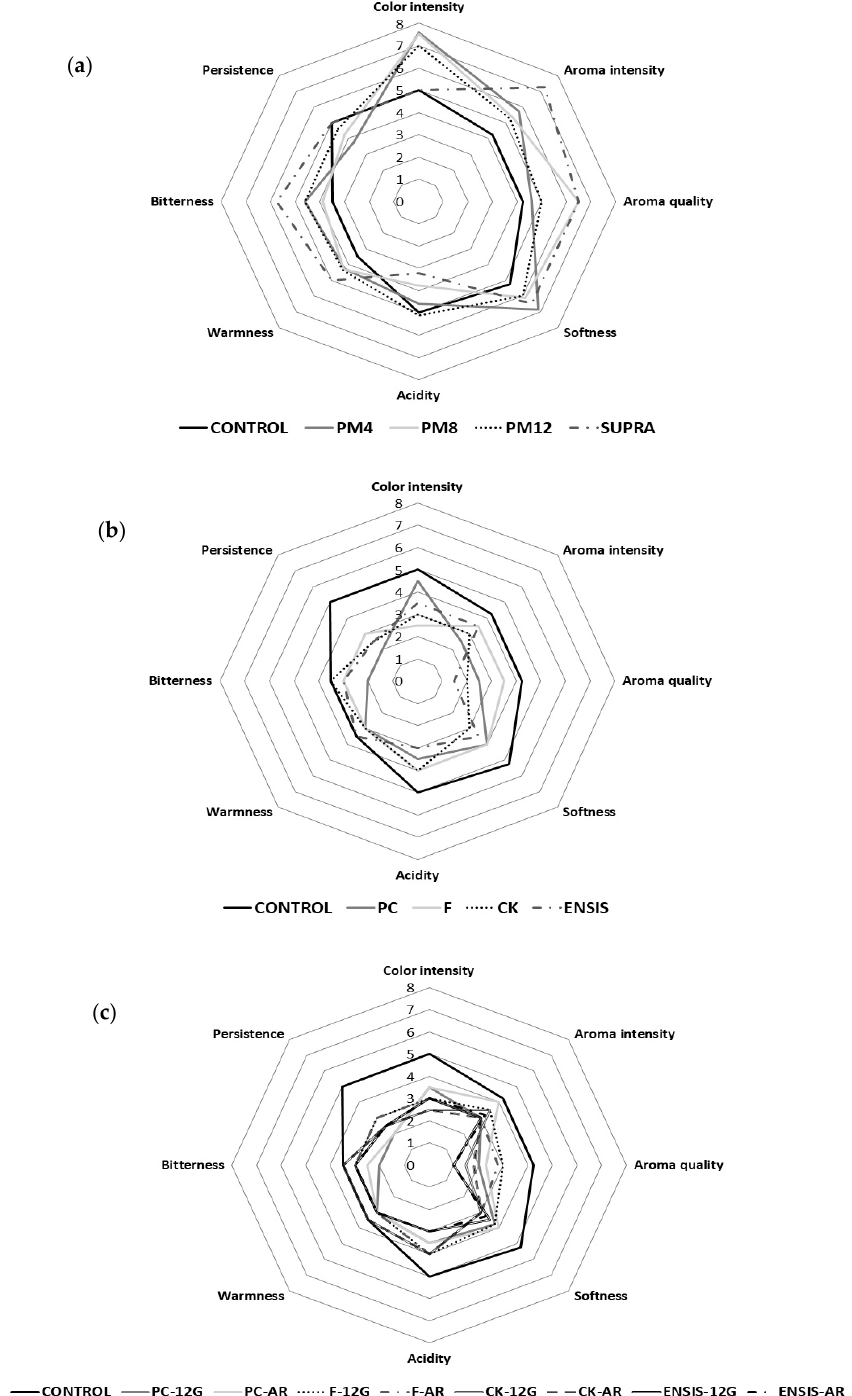
Figure 4. Effect of winemaking technique on sensorial analysis: results of Palomino fino wines compared to the control wine. ( a ) Extractive techniques of pellicular maceration (PM) and supra-extraction (SUPRA); ( b ) aroma-release technique using yeast strains (PC, F, CK and ENSIS); ( c ) aroma release-technique using the β - glycosidase enzymes AR and 12G.